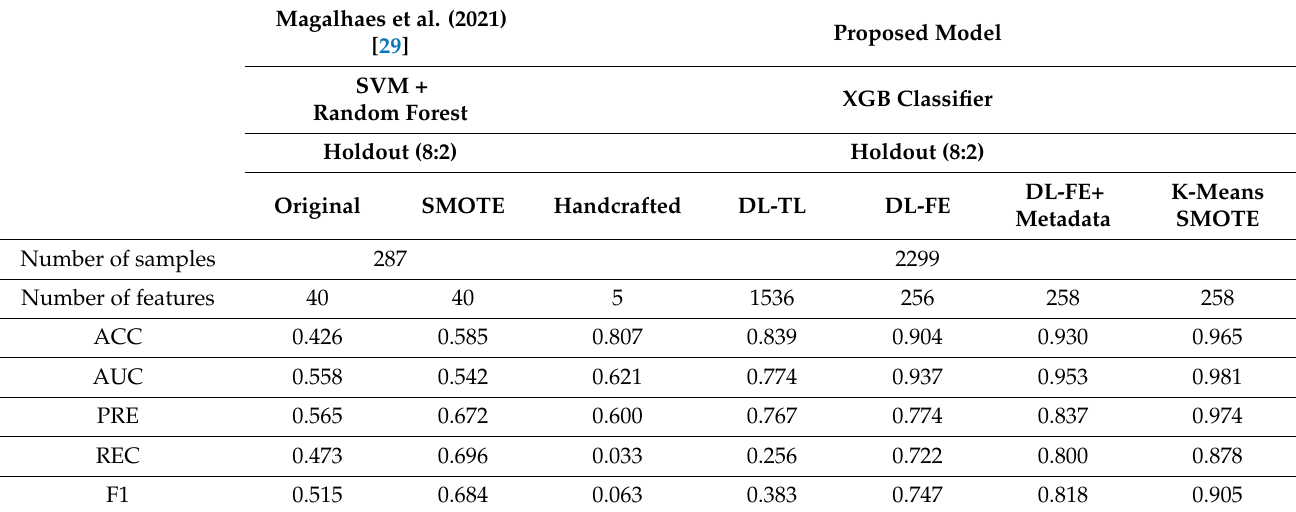
Table 13. Performance comparison with Magalhaes et al. [29].